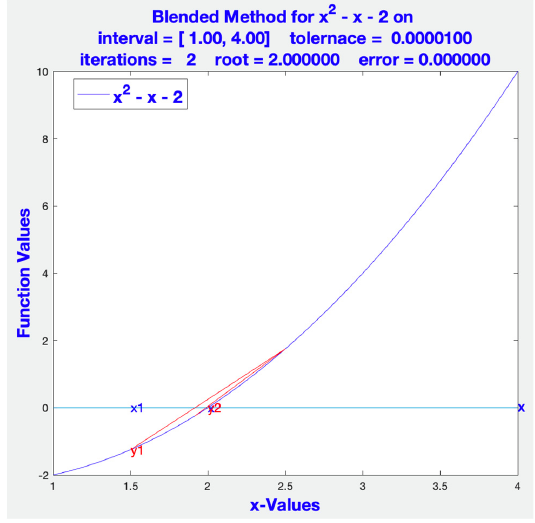
Figure 5. Plot of blended algorithm execution. Table 3. Blended algorithm efficiency iterations, AppRoot, error and interval bounds.